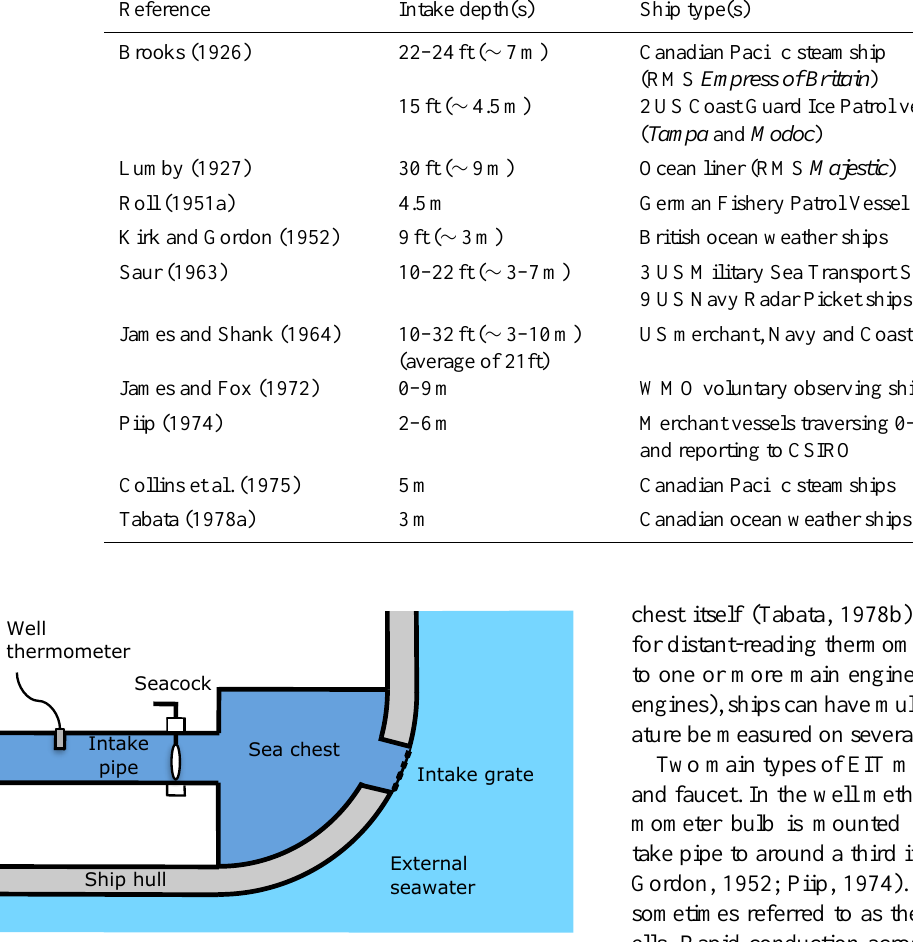
Fig. 1. Schematic of a typical engine cooling water intake system on a modern merchant